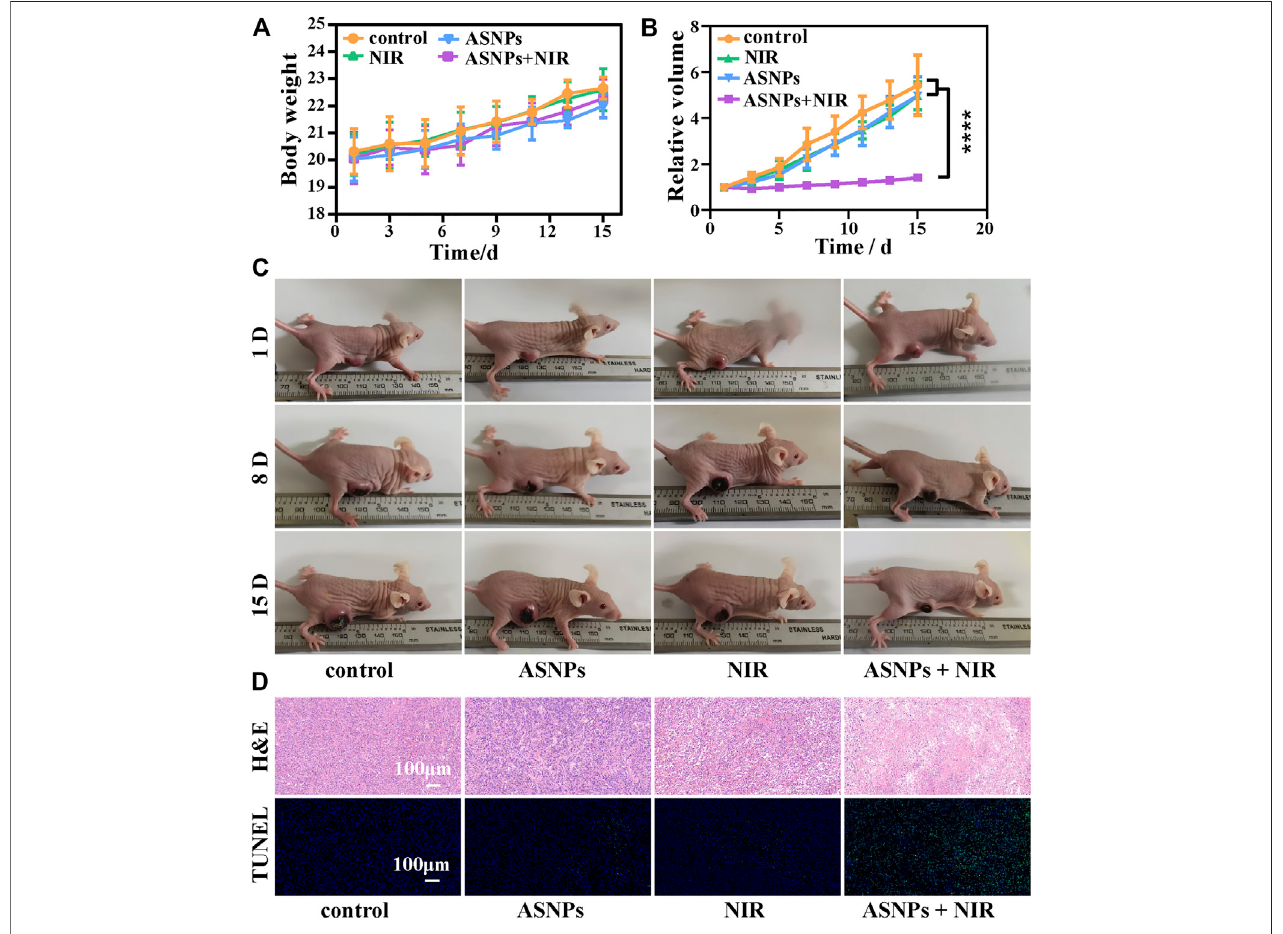
FIGURE 6 | In vivo PTT and PEDT performance of ASNPs. (A) Body weights, (B) relative tumor volumes, and (C) photos of mouse with different treatments (15 mg/kg for i. v. injection, 808-nmNIR laser:1 W/cm 2 ,5 min) inthetherapeutic process. (D) H&E and TUNEL-stainedtumor tissues indifferenttreatmentgroups. ( n = 5, mean ± SD; **** p <